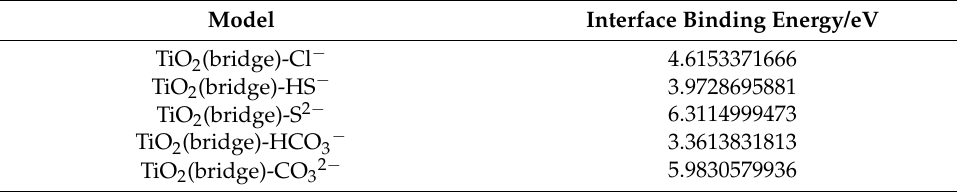
Table 5. Interface binding energies of five ions on TiO 2 (100) surface at bridge sites.